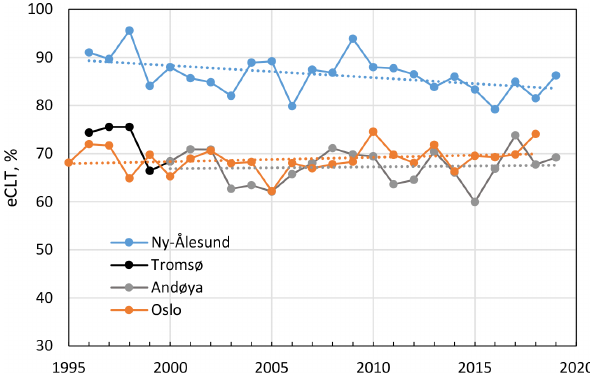
Figure 12. Annual average noontime eCLT measured in Oslo, Tromsø/Andøya, and in Ny-Ålesund from 1995/1996 to 2019. Trends in eCLT are indicated as dotted lines.